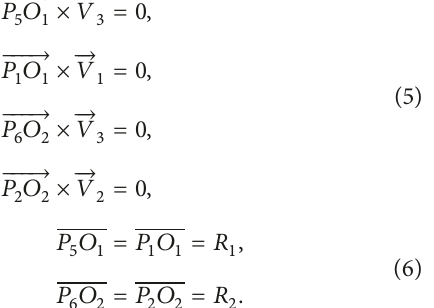
Figure 1: The illustration of the typical 3D 𝐶𝑆𝐶 curve.